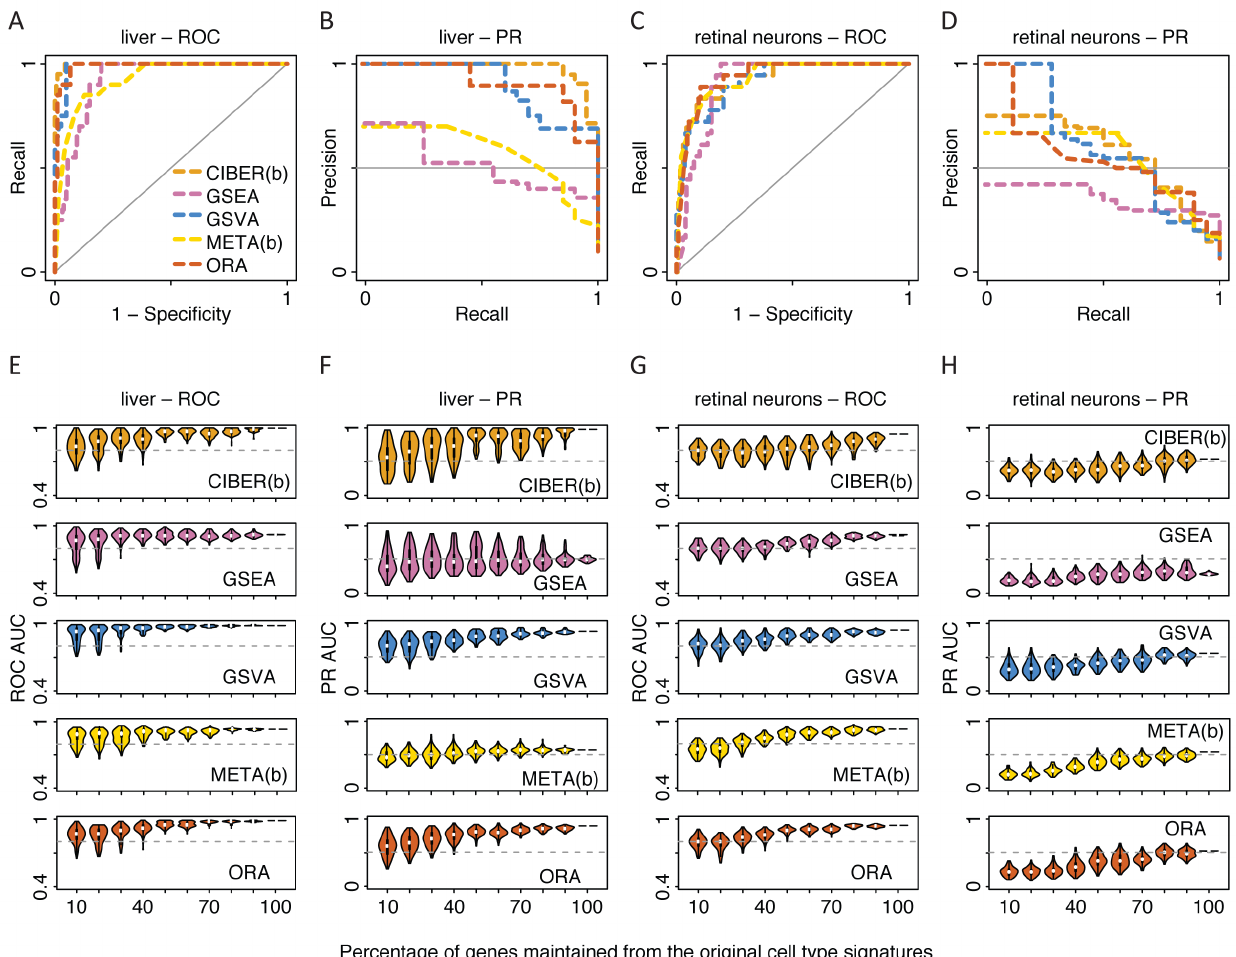
Figure 2. Performance and robustness analysis of cell type prediction methods using liver and retinal neuron scRNA-seq data. Receiver operating characteristic (ROC) and precision-recall (PR) curve analyses of five automated cell type prediction methods: CIBERSORT (CIBER(b)), GSEA, GSVA, METANEIGHBOR (META(b)) and ORA (Table 2) using a human liver scRNA-seq dataset to compute ROC curve analysis ( A ) and PR curve analysis ( B ); using a mouse retinal neuron scRNA-seq dataset to compute ROC curve analysis ( C ) and PR curve analysis ( D ). The cell type gene expression signatures used for ROC and PR curve analyses for panels A to D were randomly subsampled 1,000 times, keeping 10 to 100% of genes from the original signatures each time. Automated cell type prediction was repeated for each subsample, and violin plots representing the distribution of resulting ROC AUCs and PR AUCs are shown for analyses using human liver cells to compute ROC AUC robustness ( E ) and PR AUC robustness ( F ), and using mouse retinal neurons to compute ROC